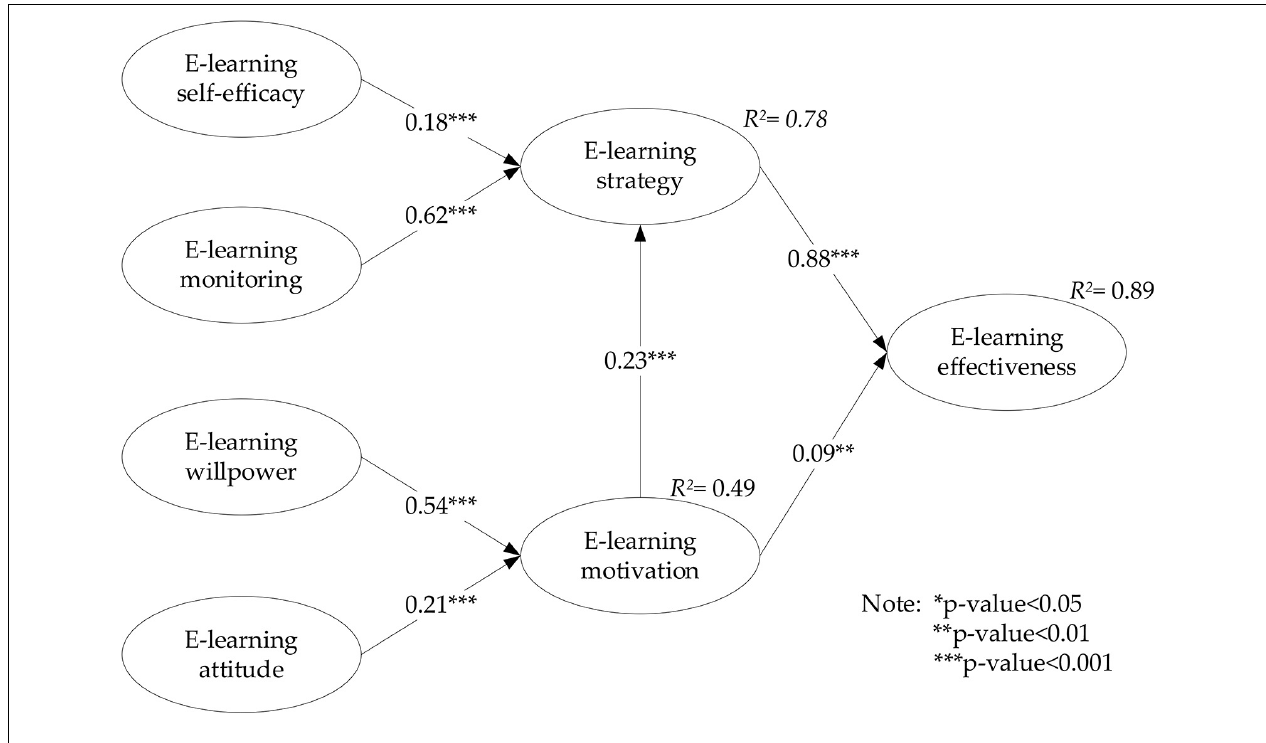
FIGURE 2 | Structural model